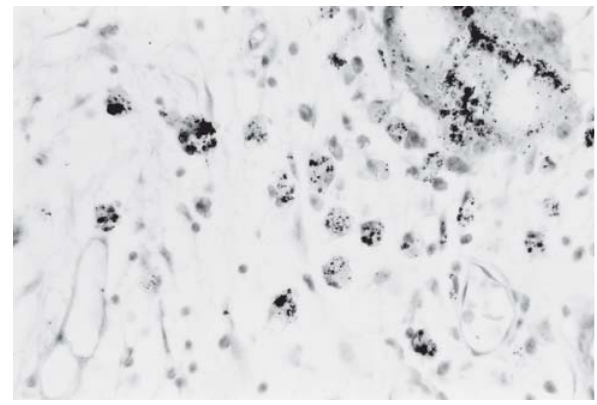
FIGURE 7 - Sealer 26. There are macrophages and giant cell with particles of the filling material in their cytoplasm. H.E. X 200